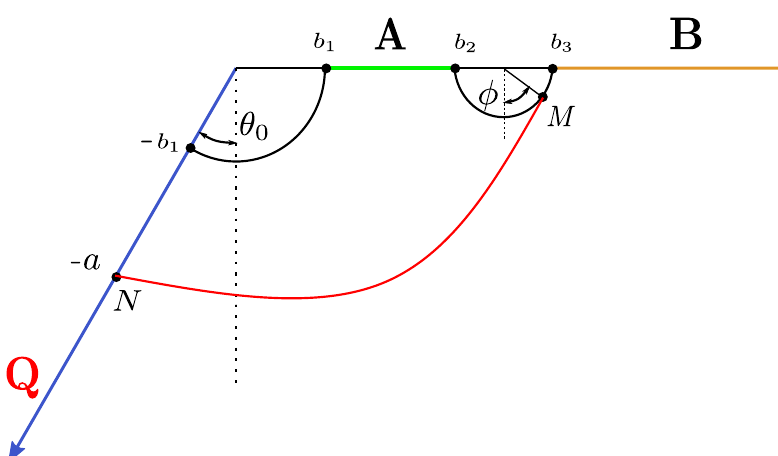
Figure 9. Calculation of the bulk entanglement wedge corresponding to the mixed state configu- ration of the two disjoint intervals A = [ b 1 , b 2 ] and B = [ b 3 , ∞ ] in the usual AdS 3 / BCFT 2 setup. Figure modified from